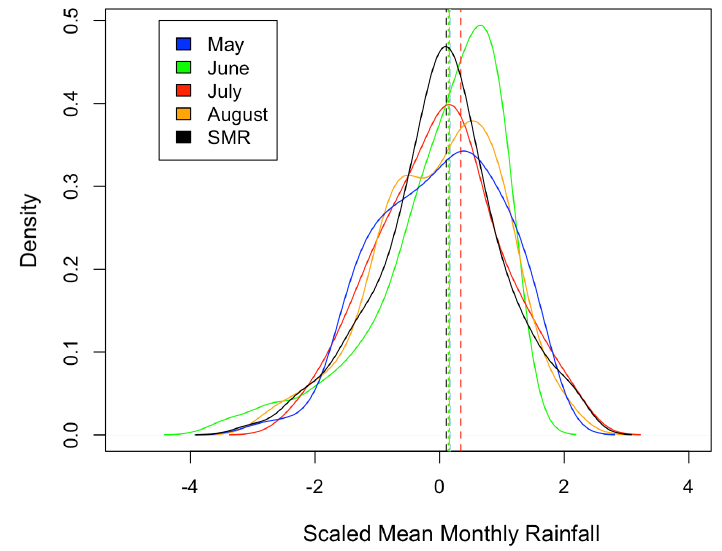
Figure 9. Density distribution curves derived from mean monthly rainfall values from 1979 to 2018 for May (blue), June (green), July (red), August (orange), and the mean seasonal rainfall (black). Table 5. Summary of minimum, mean, and maximum RMSE (mm) values for the bias-corrected daily rainfall from 1979–2018 for each ensemble member in Table